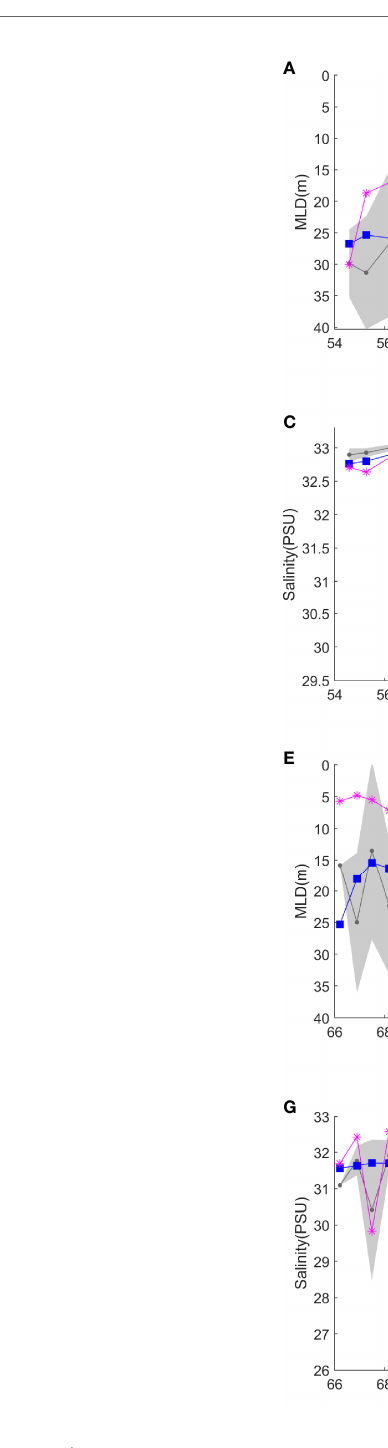
FIGURE 5 | The inter-annual variation of MLD, temperature, salinity, and density of the mixed layer from the Chinese National Arctic Research Expeditions and the climatological MLD from the WOA along the BL [ (A – D) ] and R [ (E – G) , and (H) ] sections. The gray line was the mean MLD from the data of 1999, 2003, 2010, 2012, and 2014. The shaded area was the standard